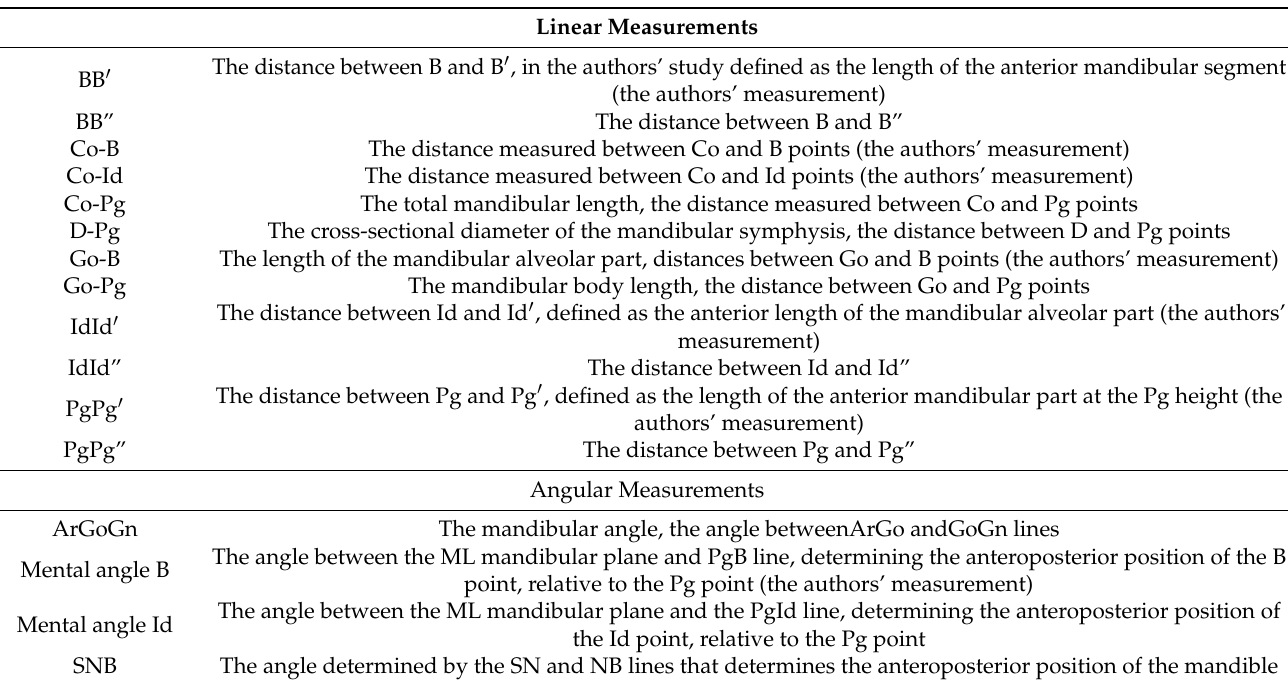
Table 2. The linear and angular measurements used in this study. Linear